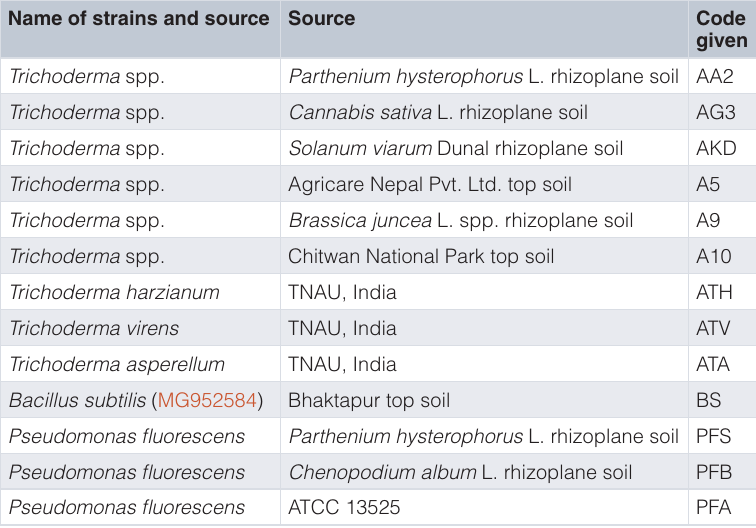
Table 1. Biocontrol agents used to analyze bio-efficacy against Ralstonia spp. This includes the shortcode given to the isolates for identification in this study. Name of strains and source